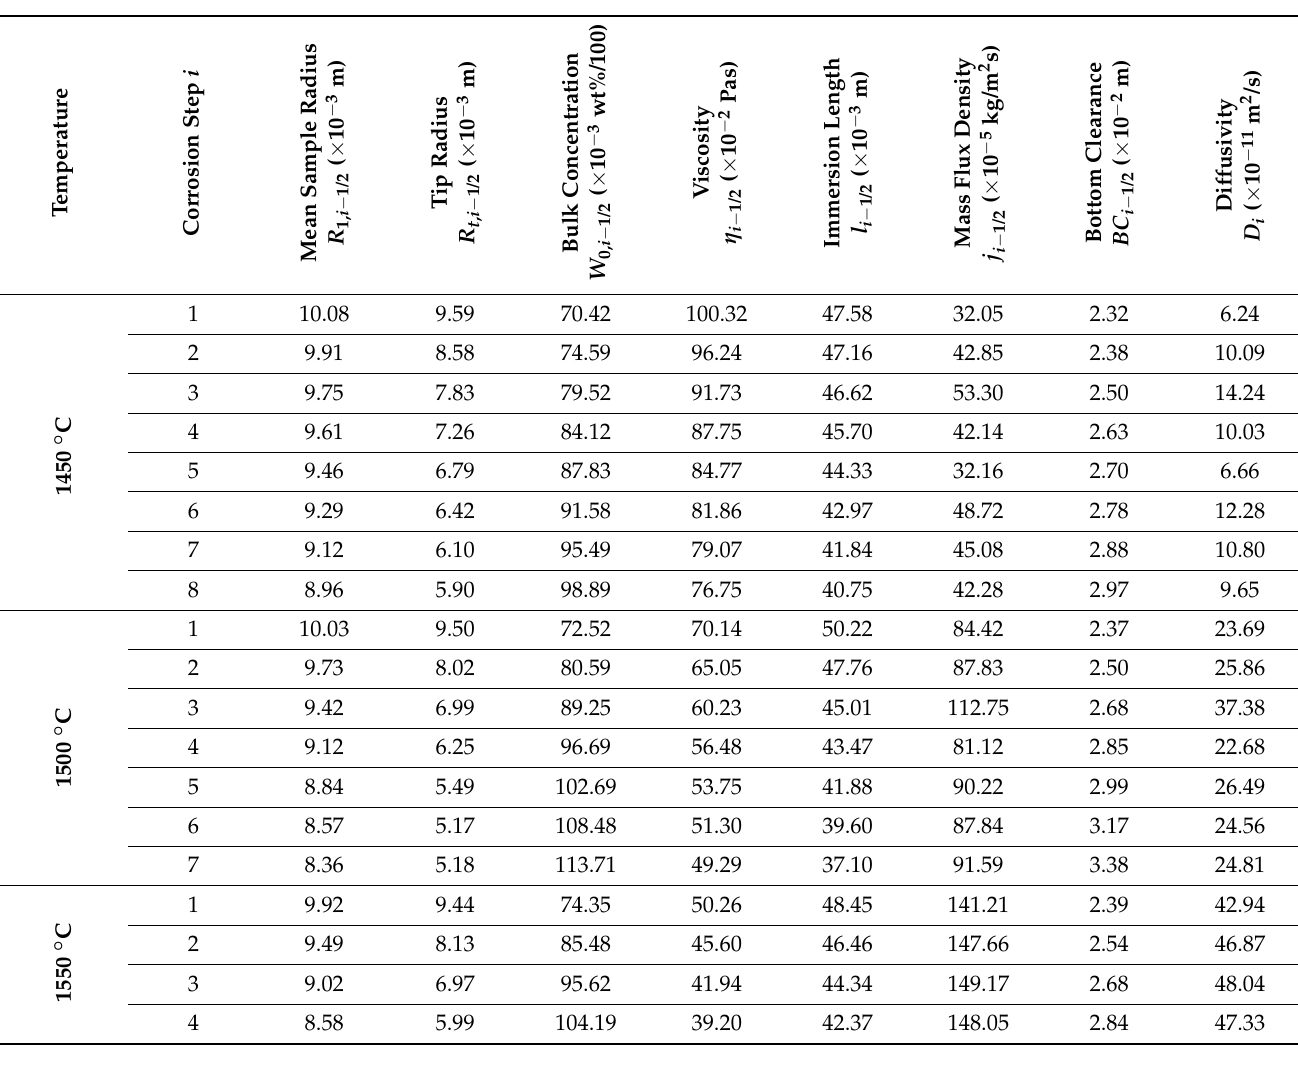
Table 2. Dissolution parameters used for the diffusivity calculation of magnesia at 1450, 1500, and 1550 ◦ C.